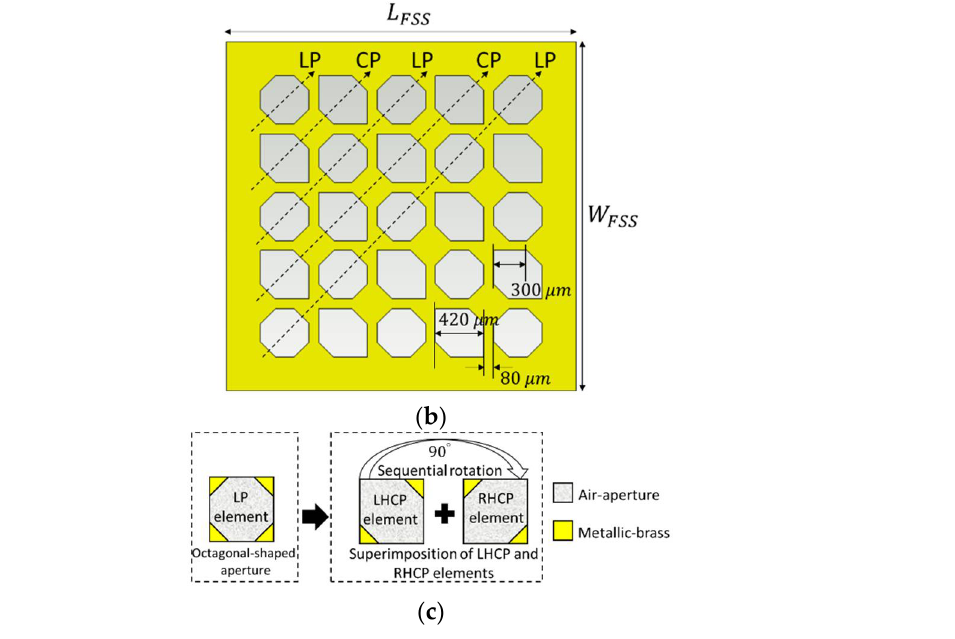
Figure 1. 300 GHz CP-RCA: ( a ) exploded model view of 7-layered-structures (brass used for all layers) [25]; ( b ) top view of metasurface layer (dimensions is inset); and ( c ) graphical demonstration of the working principle of the proposed LP octagonal-shaped aperture. Table 1. Design parameters dimensions (units: mm).